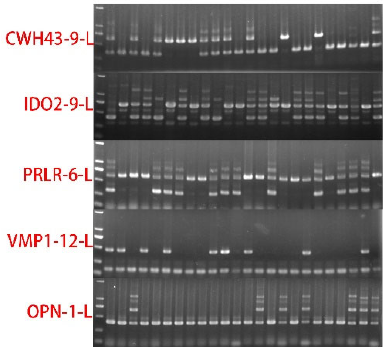
Figure 3. The five RIPs in the breed of Large White pigs ( n = 24).